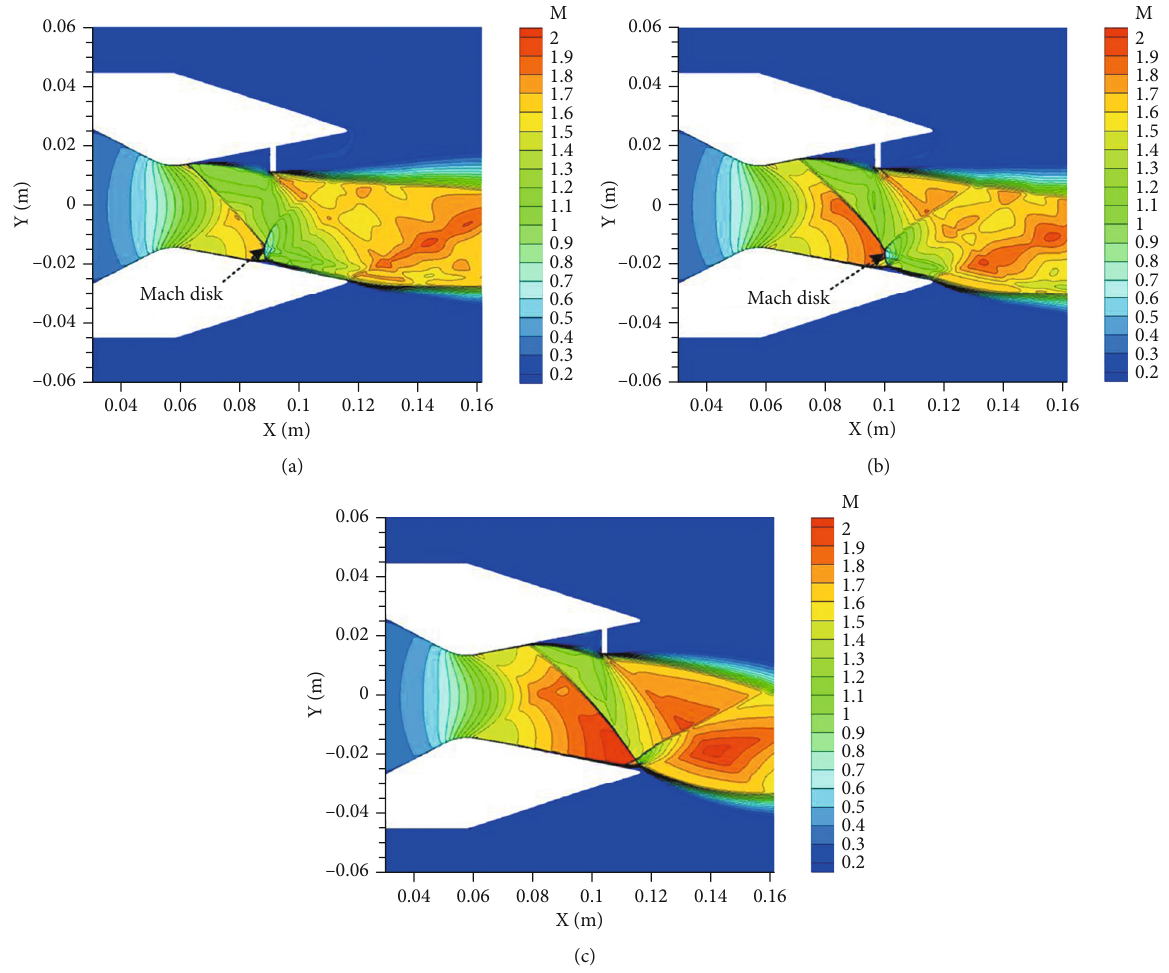
Figure 16: Mach contours for diverse rod locations ( NPR = 4 : 6 and H / R